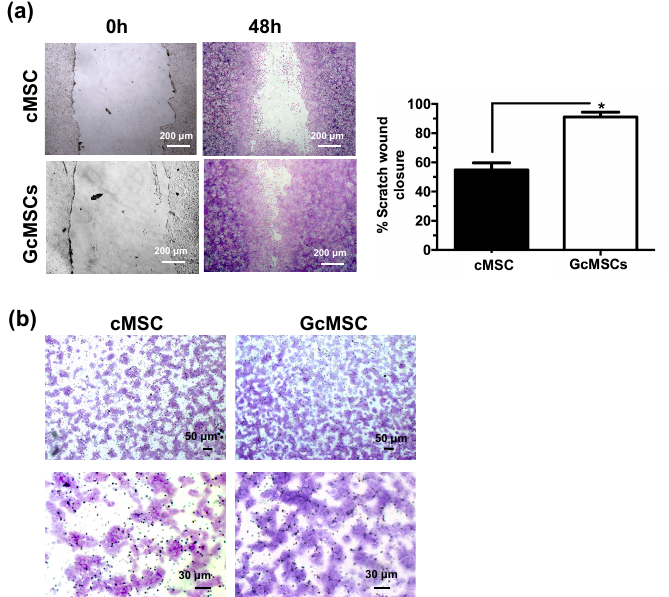
Figure 7. Prolonged GSGa treatment improves cMSC migration. ( a ) Scratch wound healing assay of GcMSC and cMSC; micrographs in the upper and lower panels were taken immediately after the scratching (0 h) and after 48 h of growth respectively. The quantification of the wounded area invaded was calculated by two independent experiments. ( b ) Micrographs of a 6 h trans-well migration assay of GcMSC and control cMSC. Cells were stained with crystal violet dye. Scale bars are 200 μ m in panel A, and 50 μ m (upper) and 30 μ m (lower) in panel B, respectively. * p value ≤ 0.05 (one-tailed Student’s t-test). Error bar indicates s.e.m.